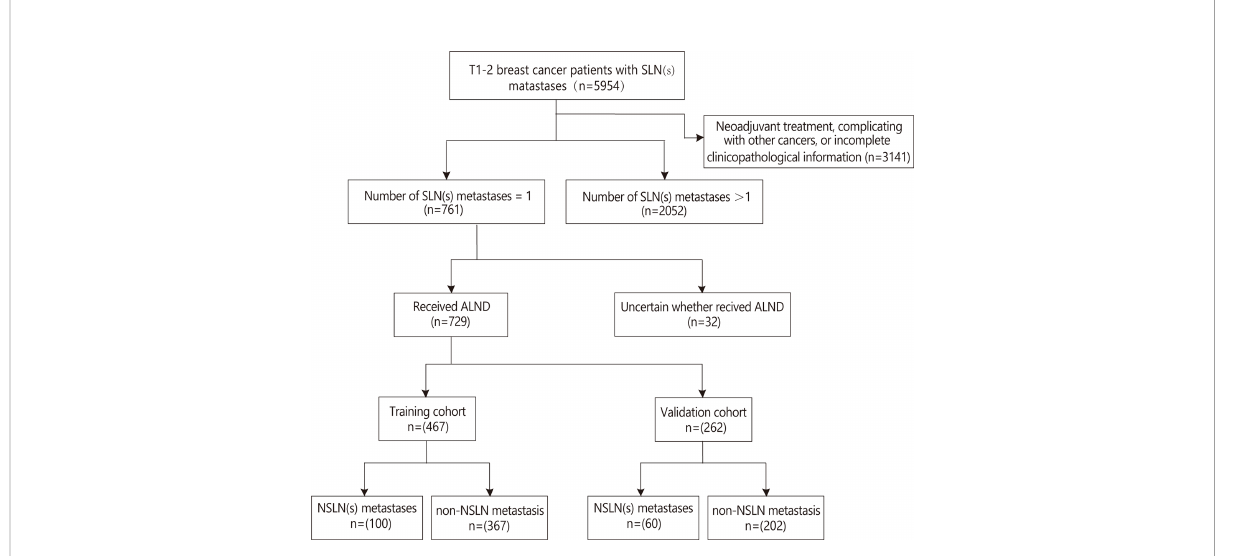
FIGURE 1 Flow diagram for the study. ALND, axillary lymph node dissection; NSLN, non-sentinel lymph node; SLN, sentinel lymph